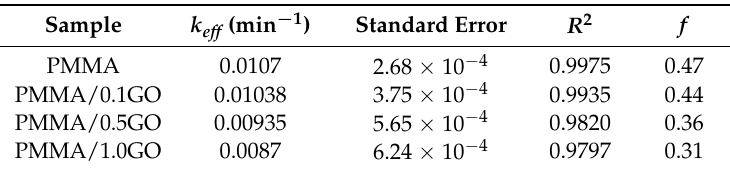
Table 1. Effective rate constant, k eff , estimated from the slope of the curves presented in Figure 5 of neat PMMA and its nanocomposites with various amounts of GO obtained in bulk polymerization and corresponding initiator efficiencies estimated from Equation